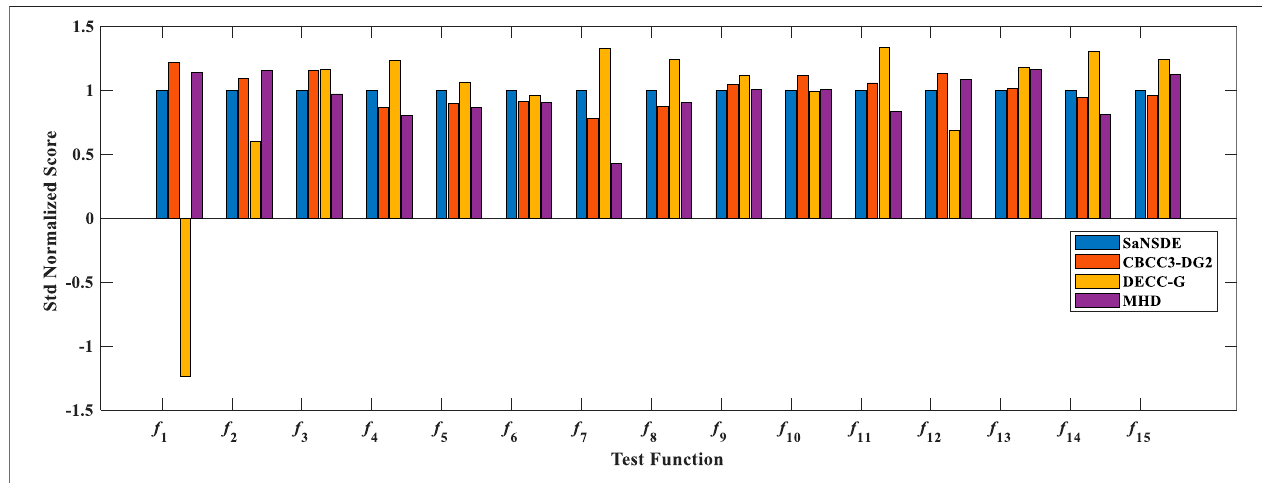
FIGURE 4 | The standard deviation normalized scores of the four algorithms. The lower the value indicates a better